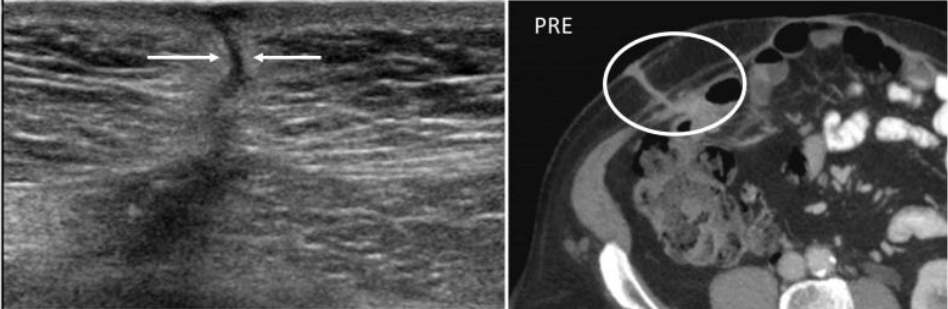
Figure 4. A 22-year- old man with reactivation of Crohn’s disease, presenting as a new enterocuta- neous fistula. B-mode US with linear transducer (first picture) shows the presence of a fistulous trait between the skin and a superficial collection (arrows). Axial not-enhanced CT scan (second picture) revealed the course of the fistula, demonstrating communication between the bowel loops and the skin, together with a small collection